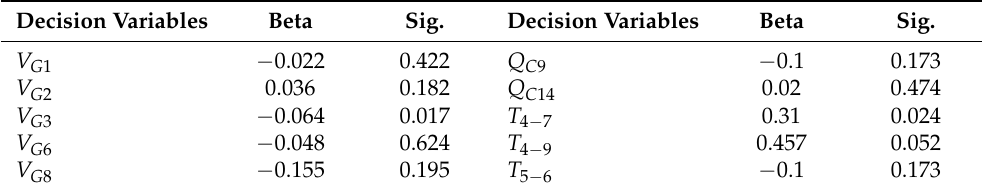
Figure 12. Validity of best ORPD results using proposed AHA-based framework: ( a ) IEEE 14 bus test system, ( b ) IEEE 39 bus test system. Table 9. Statistical significance of multiple tests runs for the IEEE 14 bus test system optimized by the proposed framework.